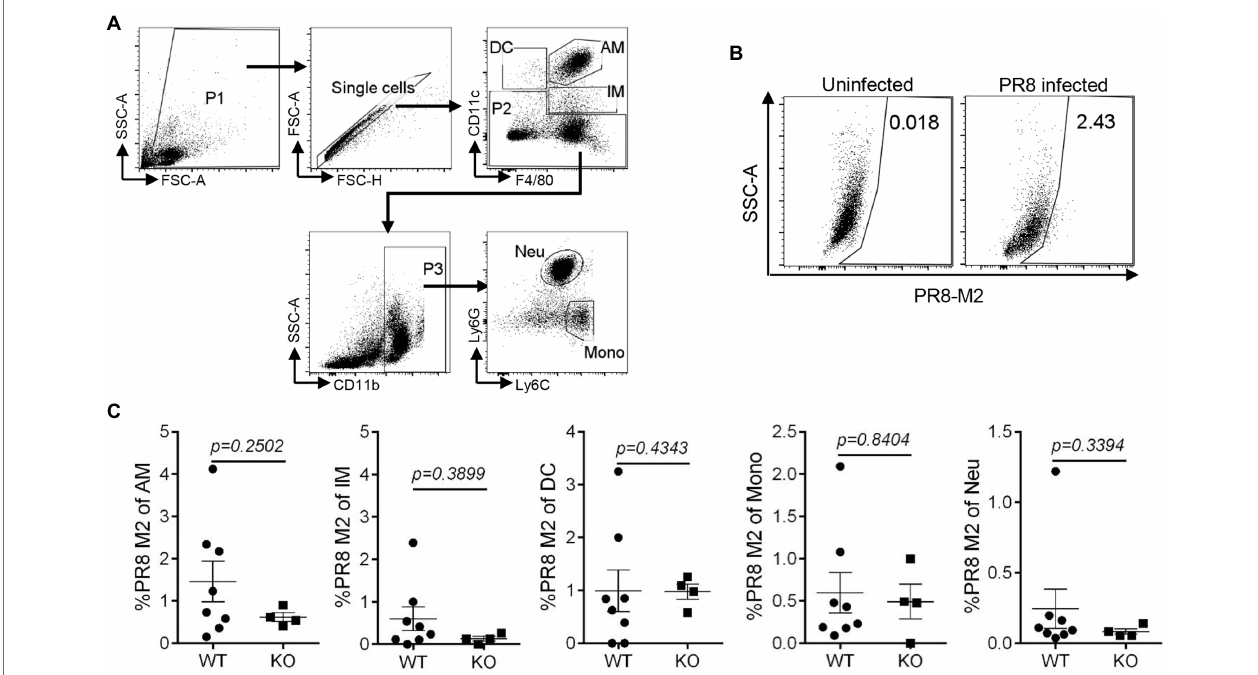
FIGURE 7 | IL16 deficiency does not affect IAV infection in lung myeloid cell subsets. Seven-week-old male WT and IL16 KO mice were intranasally infected with PR8 virus (8,000 PFU), and control mice received mock inoculation with PBS. Lungs from the infected mice were harvested on day 2 post-infection. PR8 M2 expression in the myeloid cell subsets was analyzed using flow cytometry. (A) The gating strategy for myeloid cell subsets. AM, alveolar macrophages; IM, interstitial macrophages; DC, dendritic cells; Mono, monocytes; Neu, neutrophils. (B) Representative plot showing PR8 M2 expression in alveolar macrophages. (C) PR8 M2 expression in different myeloid cell subsets in the lungs of infected mice. The Data shown are representative of two independent experiments, eight mice for WT group and four mice for KO group. A value of p < 0.05 was considered